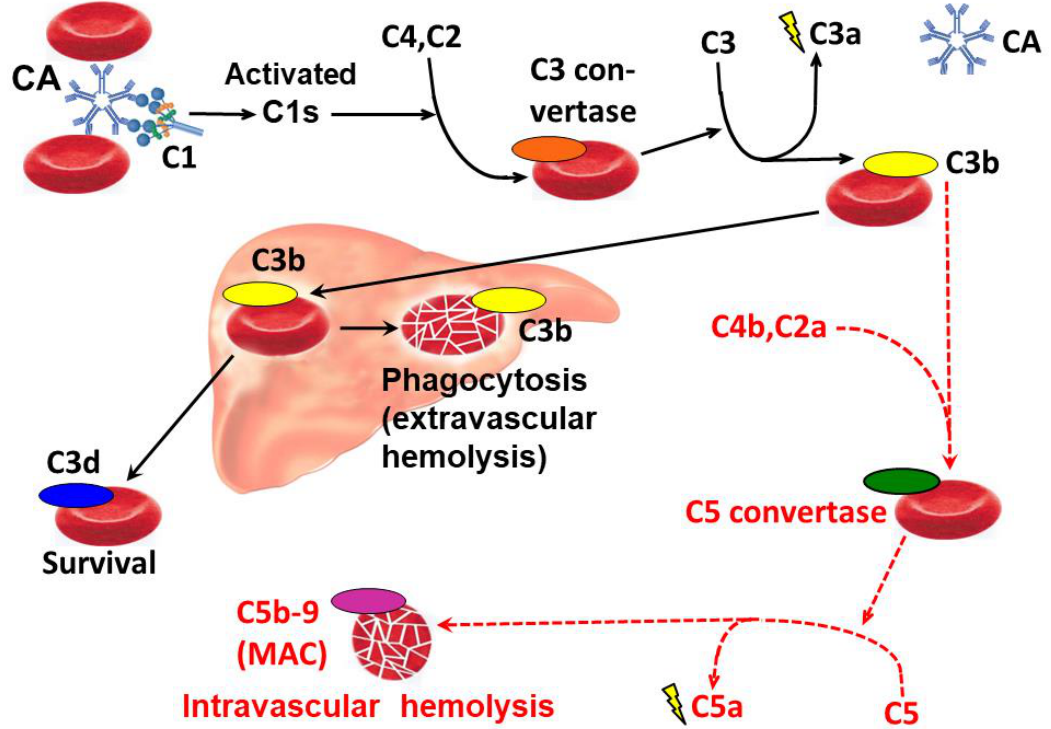
Figure 3. Complement-mediated hemolysis in CAD. Only relevant pathways are shown. On the surface of erythrocytes agglutinated by IgM cold agglutinin (CA), the antigen–antibody complex binds complement protein complex C1, which initiates the classical activation pathway. On warming to central body temperature, CA detaches from the cells. Sequential cleavage of C4, C2, and C3 leaves the erythrocytes coated with C3b, which makes them prone to extravascular hemolysis in the liver. C3b may also react to form C5 convertase, which triggers the terminal complement cascade, resulting in formation of the membrane attack complex (MAC) and intravascular hemolysis. Lightning symbols denote anaphylotoxin properties of soluble split products. Continuous black lines indicate major pathways. Dashed red lines indicate minor pathways active in severe disease.